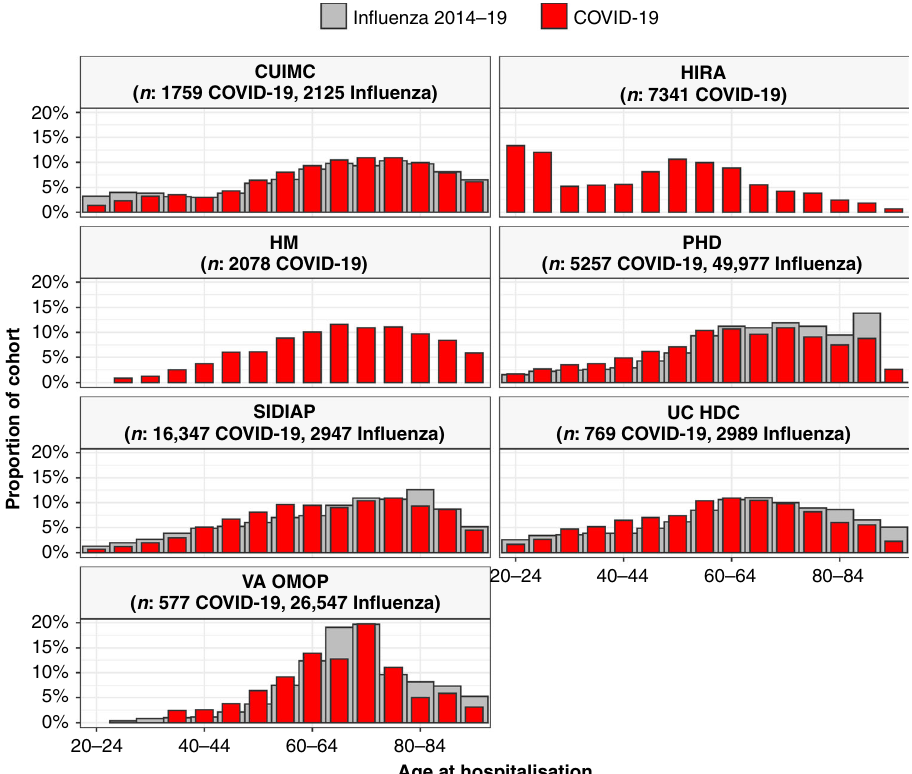
Fig. 1 Age of patients hospitalised with COVID-19 and of patients hospitalised with in fl uenza. Individuals hospitalised with COVID-19 between December 2019 and April 2020 compared with those hospitalised with in fl uenza between September 2014 to April 2019 (where available). Proportion of cohorts by 5-year age groups, with groups with counts of <10 omitted. CUIMC: Columbia University Irving Medical Center; HIRA: Health Insurance Review & Assessment; HM: HM Hospitales; PHD: Premier Healthcare Database; SIDIAP: The Information System for Research in Primary Care; UC HDC: University of Colorado Health Data Compass; VA OMOP: Department of Veterans Affairs. In fl uenza data for SIDIAP was only available from 2014 to